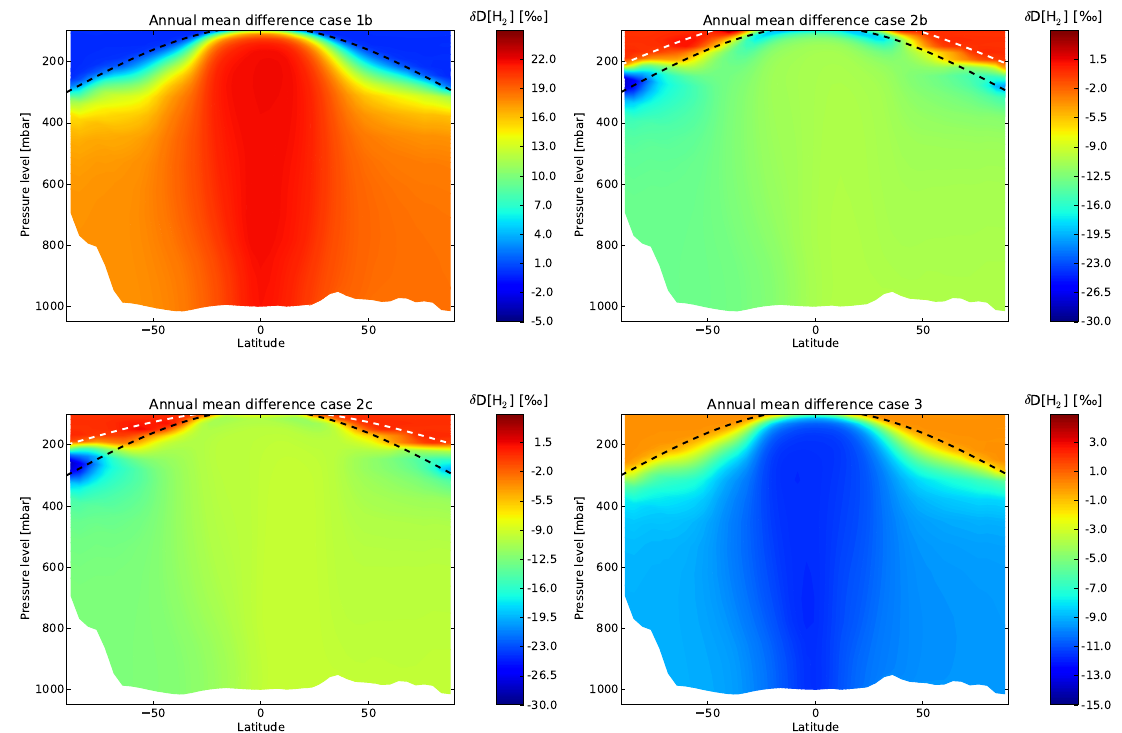
Fig. 9. Zonal annual mean differences for case 1b, case 2b, case 2c, and case 3. The reference tropospheric boundary for the stratospheric parametrisation (see Sect. 2.3) is indicated by the dashed black line. The perturbed boundaries of case 2b and 2c are indicated by the dashed white line.